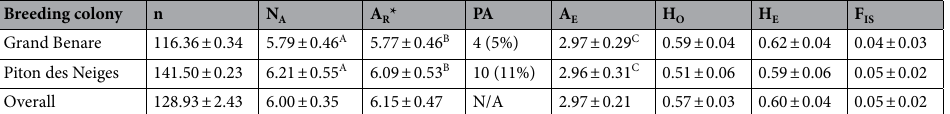
tions from Hardy–Weinberg Equilibrium at the 99% confidence level (all p values > 0.01). Thus, the proportion of rare and private alleles in both populations was notable and suggestive of fine-scale genetic drift. Measures of genetic differentiation. The F –3 ) indicated weak though ST value (0.01; p value = 2.0 × 10 statistically significant genetic structure between the two breeding colonies. This was supported by two similar estimates of genetic differentiation: G ′ ST (0.01; p value = 1.0 × 10 –3 ) and R ST (0.01; p value = 7.0 × 10 –3 ), with 8 of the 14 loci showing p values < 0.05. The comparison between F ST and R ST was statistically non-significant (p R ST = 8.0 × 10 –3 , p value = 0.28), indicating no major contribution of stepwise mutations to the observed genetic difference but rather genetic drift. Unexpectedly, following multiple approaches (Fig. 2), the best-supported model for the Bayesian clustering analysis was that of two genetic clusters using sampling location as a priori information (refer to “Methods” sec- tion). This was reinforced by the median value of L(K). The two genetic clusters correspond perfectly to the two breeding colonies, with individual membership coefficients averaging 0.85 ± 0.04 and 0.83 ± 0.04 for birds sampled from Grand Benare and Piton des Neiges, respectively (Fig. 3). The DAPC clustering procedure produced similar results to the STRU CTU RE analysis, assuming K = 2 and using the first 80 principal components. Assignment probabilities of individuals sampled at Piton des Neiges averaged 0.79 ± 0.26 for Cluster 1, and assignment prob- abilities of individuals sampled at Grand Benare averaged 0.82 ± 0.23 for Cluster 2 (Fig. 4). Effective population size and test of bottleneck. The estimates of contemporary Ne are consistent with our evaluations of genetic diversity in the two colonies. Ne for the Piton des Neiges colony was estimated at 1148 [95% CI 434–infinite] and 1376 [95% CI 527–infinite] individuals at the cut-offs of 0.05 and 0.02, respec-